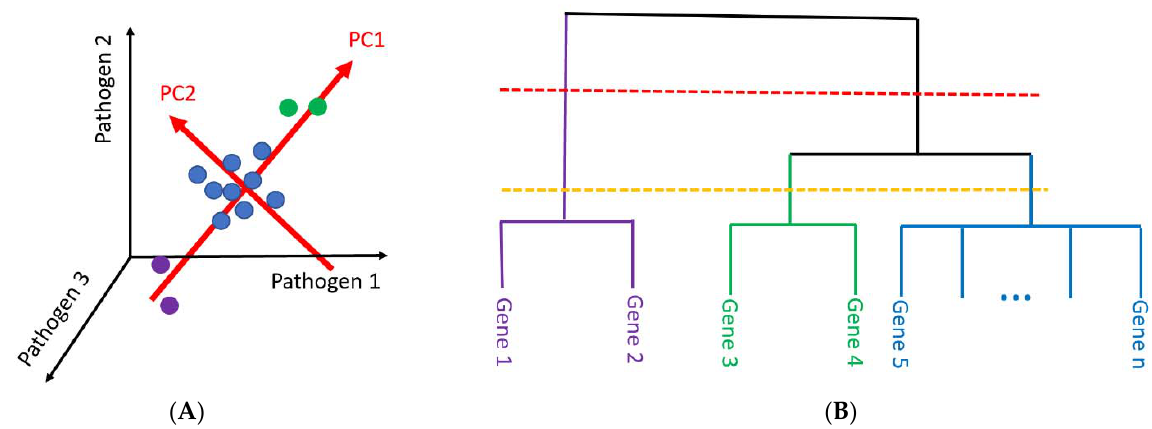
Figure 1. The schematic description of the procedure for identifying the outlier (i.e., important) genes from the dataset: ( A ) the high-dimensional space is reduced to the two dimensional PC 1 ~PC 2 space with principal component analysis (PC 1 ― principal component 1; PC 2 ― principal component 2); ( B ) genes are clustered into different groups with hierarchical clustering ― two clusters (by the red-dashed line) or three clusters (by the orange-dashed line) or other numbers of clusters (not further clusters shown here due to the space constraint). The optimal number of clusters was determined by the bending point in the plot of the sum of the total variance of within individual clusters.